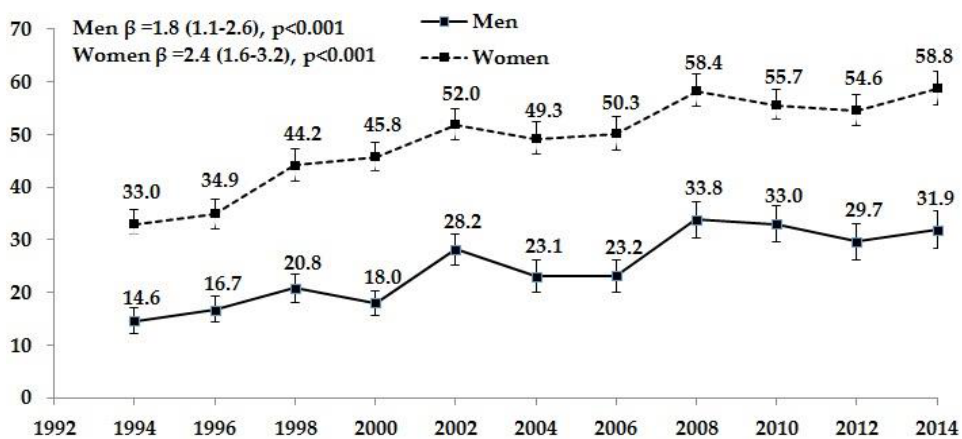
Figure 1. Proportion (%) of men and women brushing teeth at least twice a day in 1994–2014 (edentulous individuals are excluded).